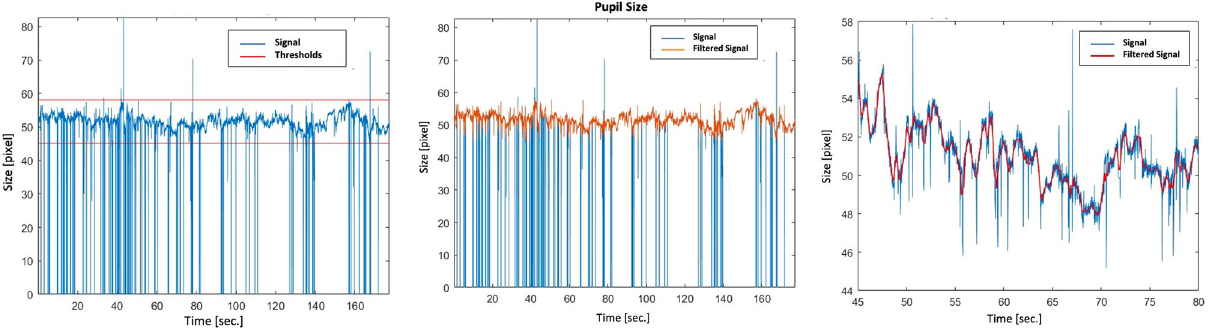
Figure 5. Processing of the pupil signal. In the first graph, thresholds are in red; in the second graph signal after threshold is in orange; in the third graph averaged mean filtered signal is in red; in all graphs raw signal is in